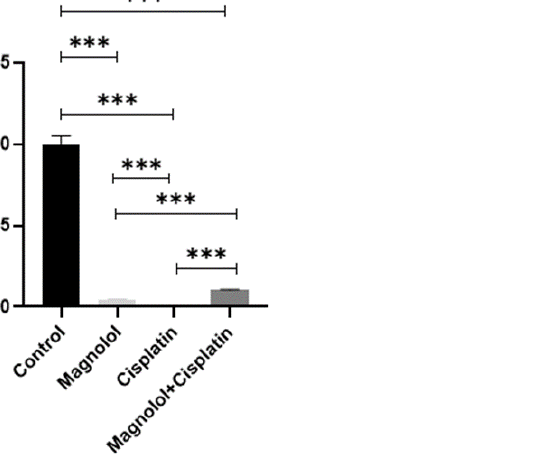
Figure 6. Changes in MMP-9 wxpression following magnolol and/or cisplatin therapy treatment of MKN-45 cells with magnolol and/or cisplatin resulted in a substantial decrease in MMP9 expression compared to the control group. β -actin was used as the reference gene for normalizing the relative quantitative expression of target genes. All experiments were performed in triplicate. *** p <